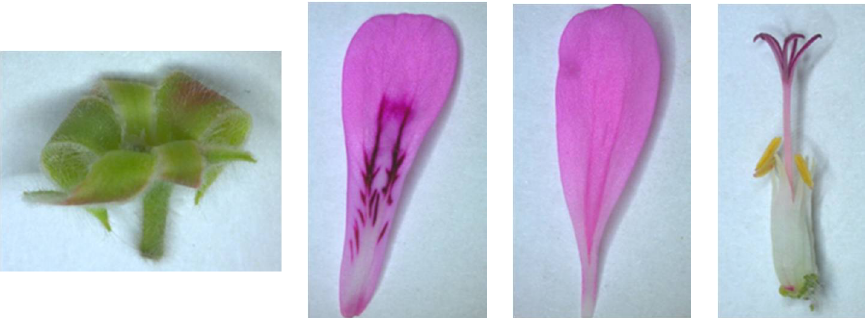
Figure 2. Sepals, petals and stamens/pistils of the flower of P. ‘Endsleigh’ at full bloom stage.